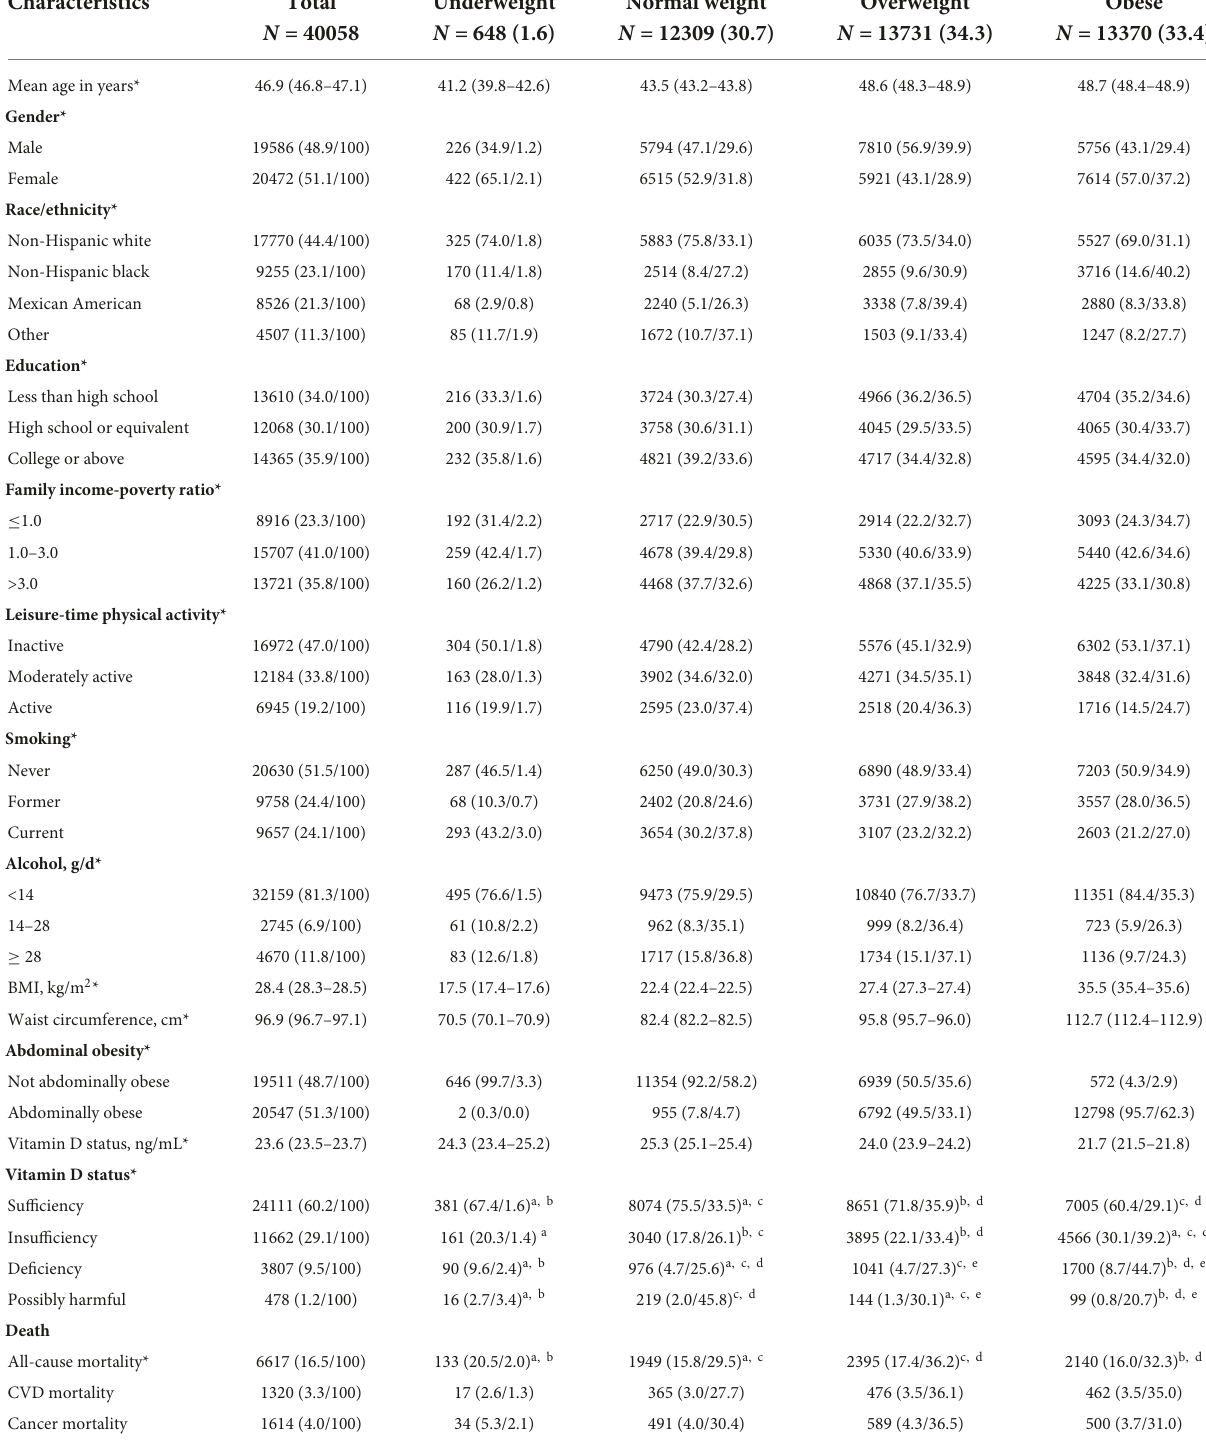
TABLE 1 Baseline characteristics of participants from US National Health and Nutrition Examination Survey (US NHANES) III and 2001–2014.